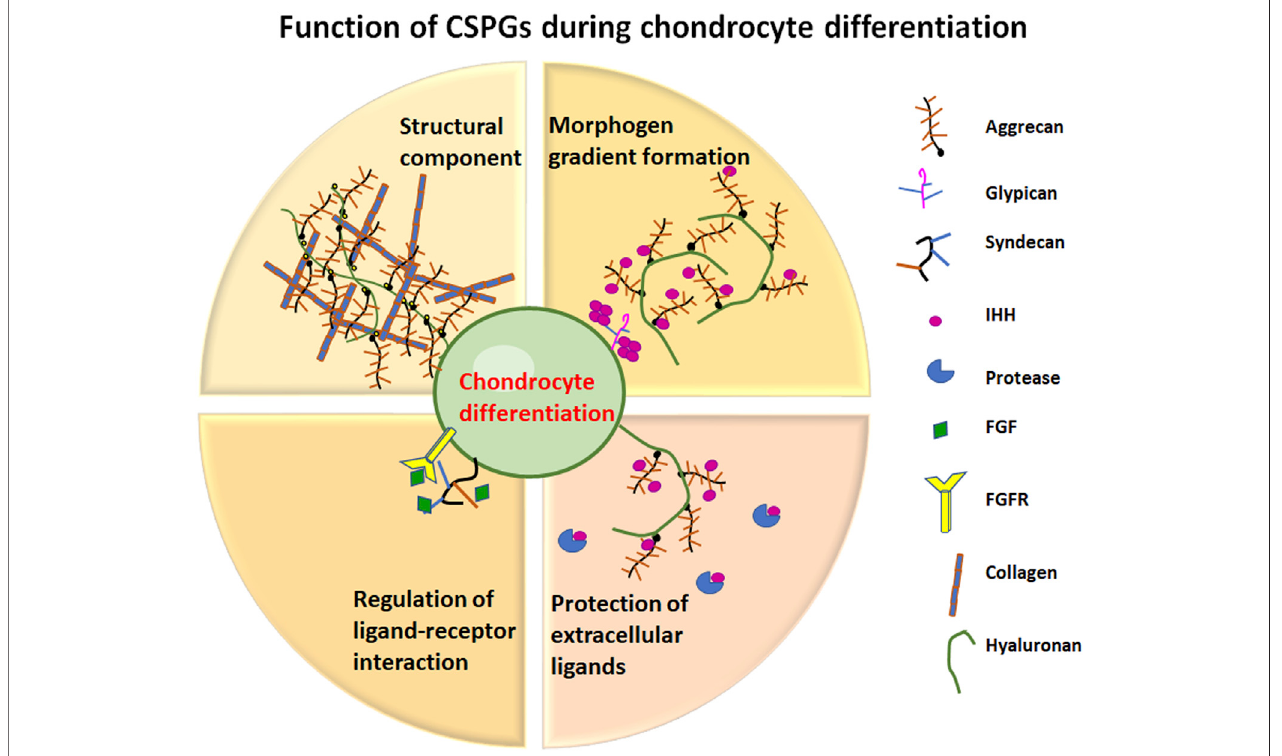
FIGURE 3 | Function of CSPGs during chondrocyte differentiation. Representation of the different roles that CSPGs play in cartilage development.